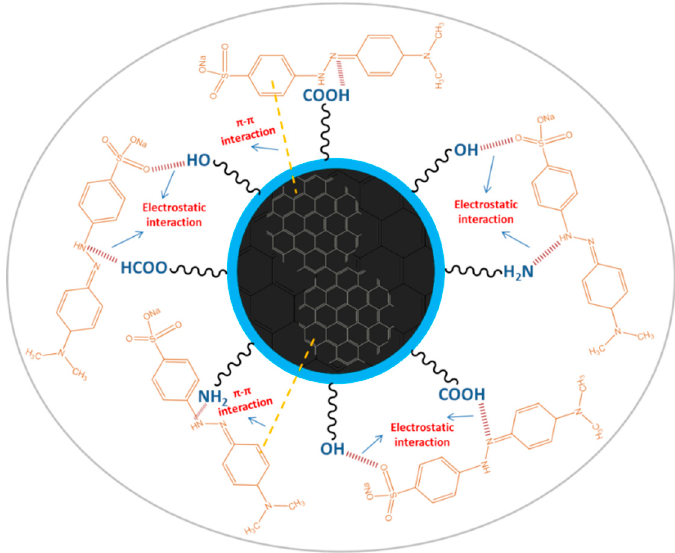
Figure 11. A schematic illustration representing plausible interactions between the AC-NCDs and MO.